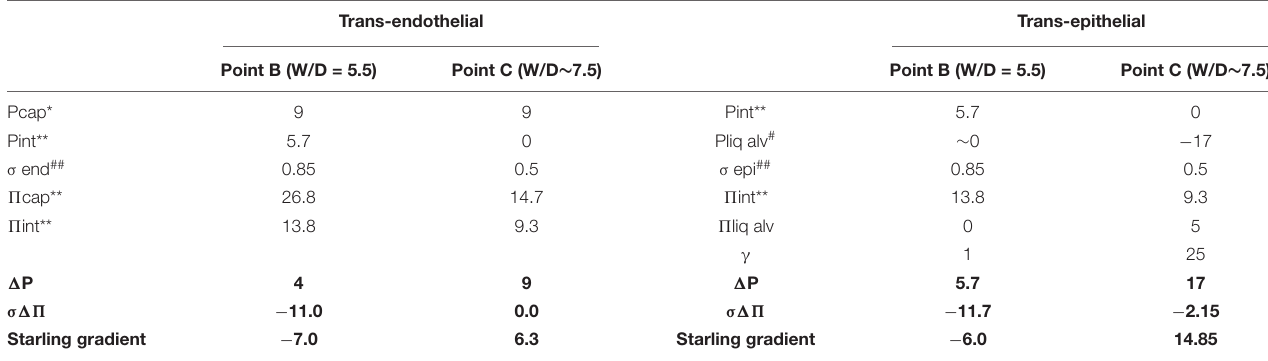
TABLE 2 | Trans-endothelial and trans-epithelial Starling pressure gradients at end-expiration, with “safety factor” (point B in Figure 4 ) and after some degree of matrix fragmentation (point C in Figure 4 ).